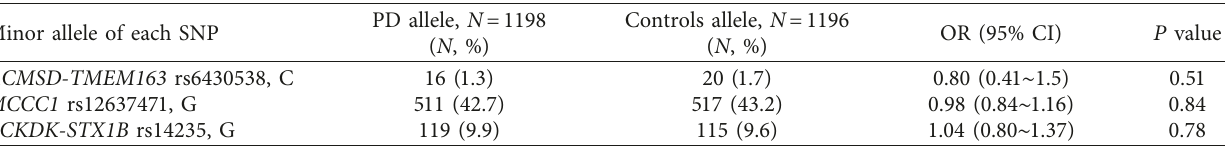
Table 2: Comparisons of minor allelic frequencies of single nucleotide polymorphisms (SNPs) between Parkinson’s disease (PD) patients and the controls.